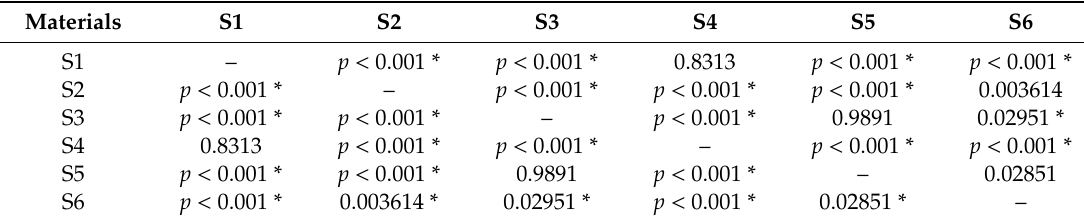
Table 10. Di ff erences in ∆ E after 168 h immersion in soy